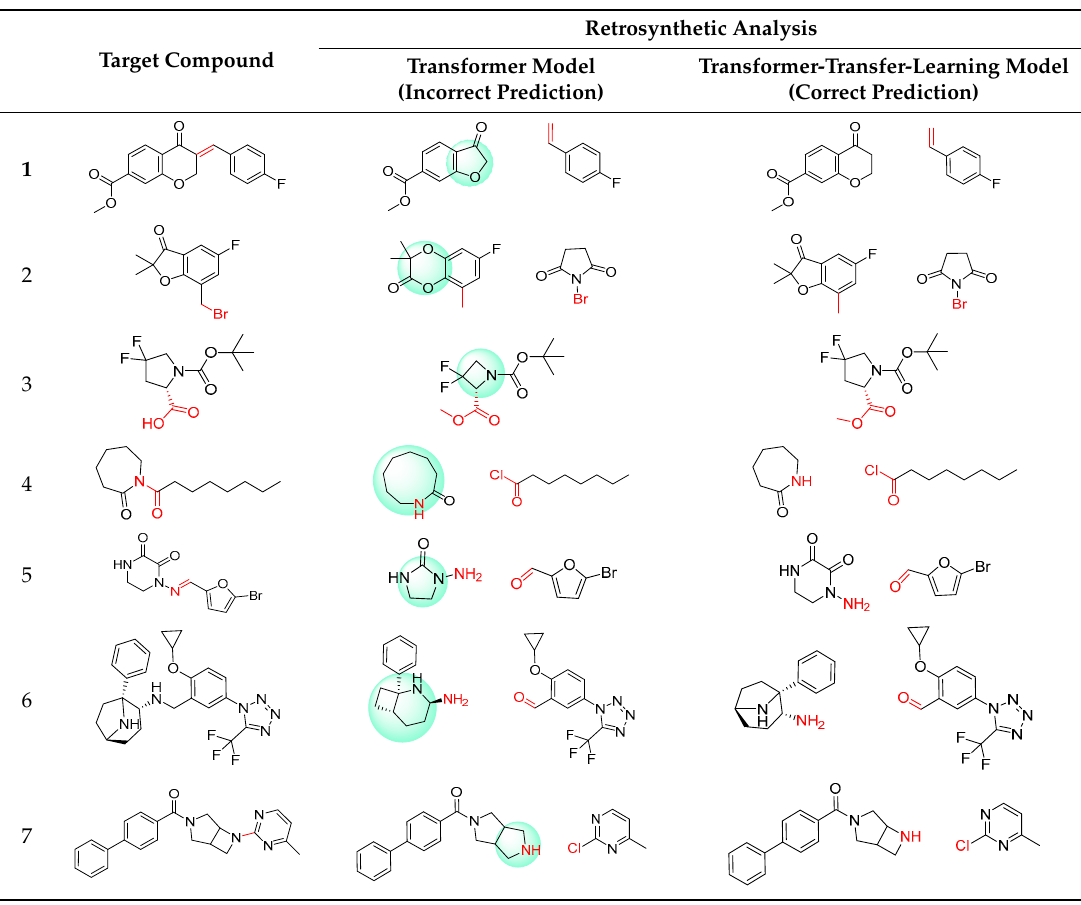
Table 6. Comparisons and representative examples (selected from the test set) of the Transformer and Transformer-transfer-learning models in retrosynthetic prediction with nonaromatic heterocycle structures.